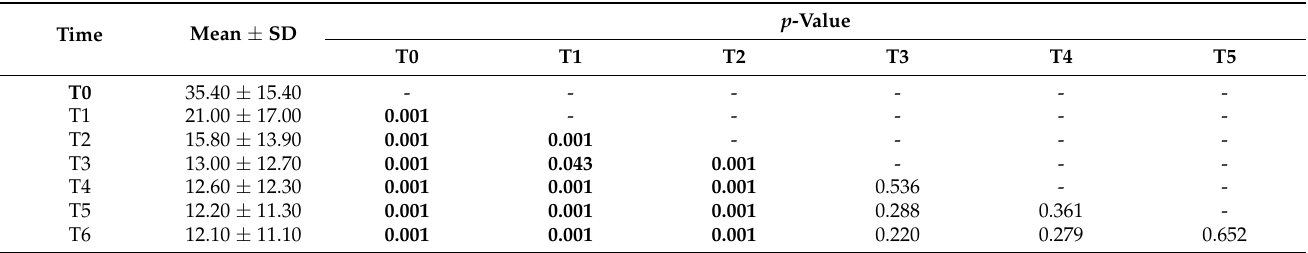
Table 3. Comparison of ODI score over the preoperative times (T0), 2 days (T1), 1 month (T2), 3 months (T3), 6 months (T4), 12 months (T5), and 24 months (T6) postoperatively.